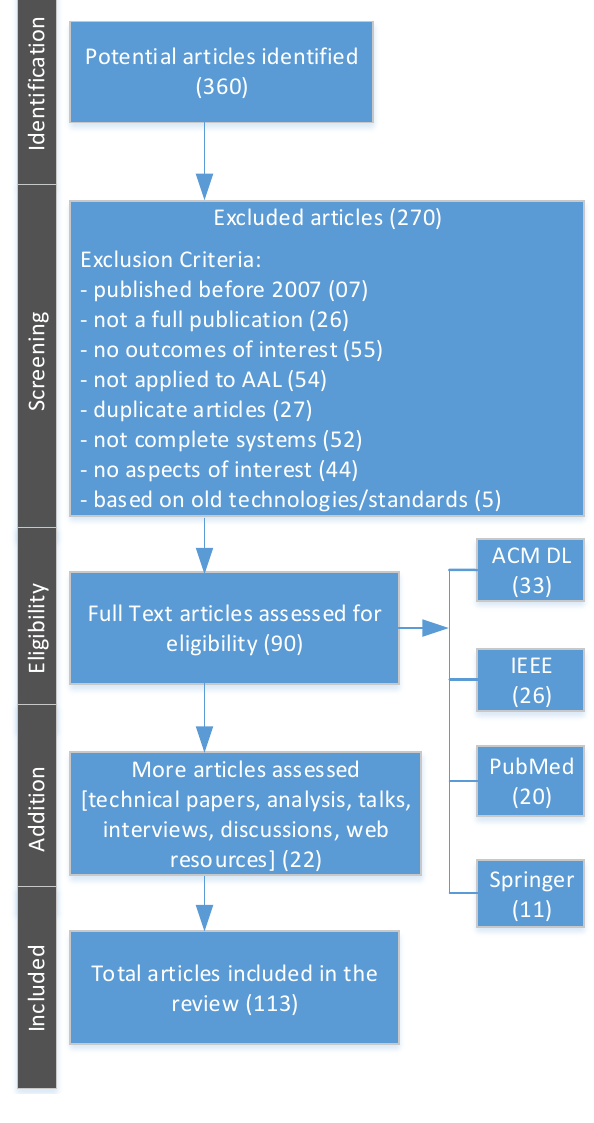
Figure 1. Search strategy and exclusion process for literature review of